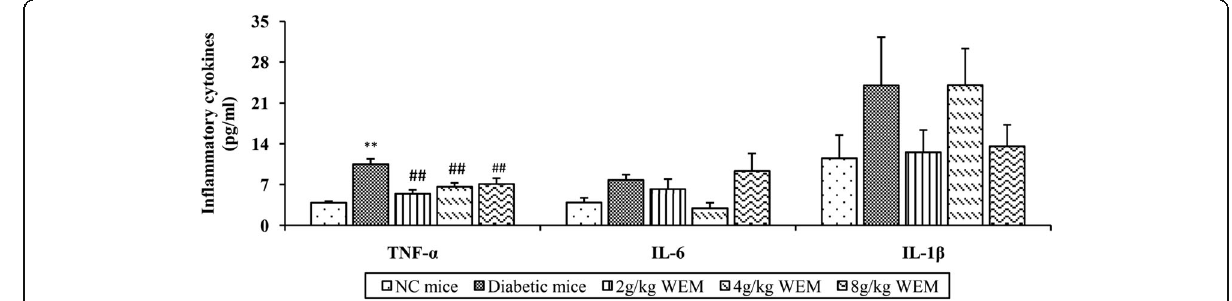
Fig. 5 TNF- α , IL-1 β and IL-6 were determined in the serum by ELISA. Bars represent means ± SEM ( n = 5). * P < 0.05, **P < 0.01, NC mice vs. Diabetic mice; # P < 0.05, ## P < 0.01, WEM vs. Diabetic